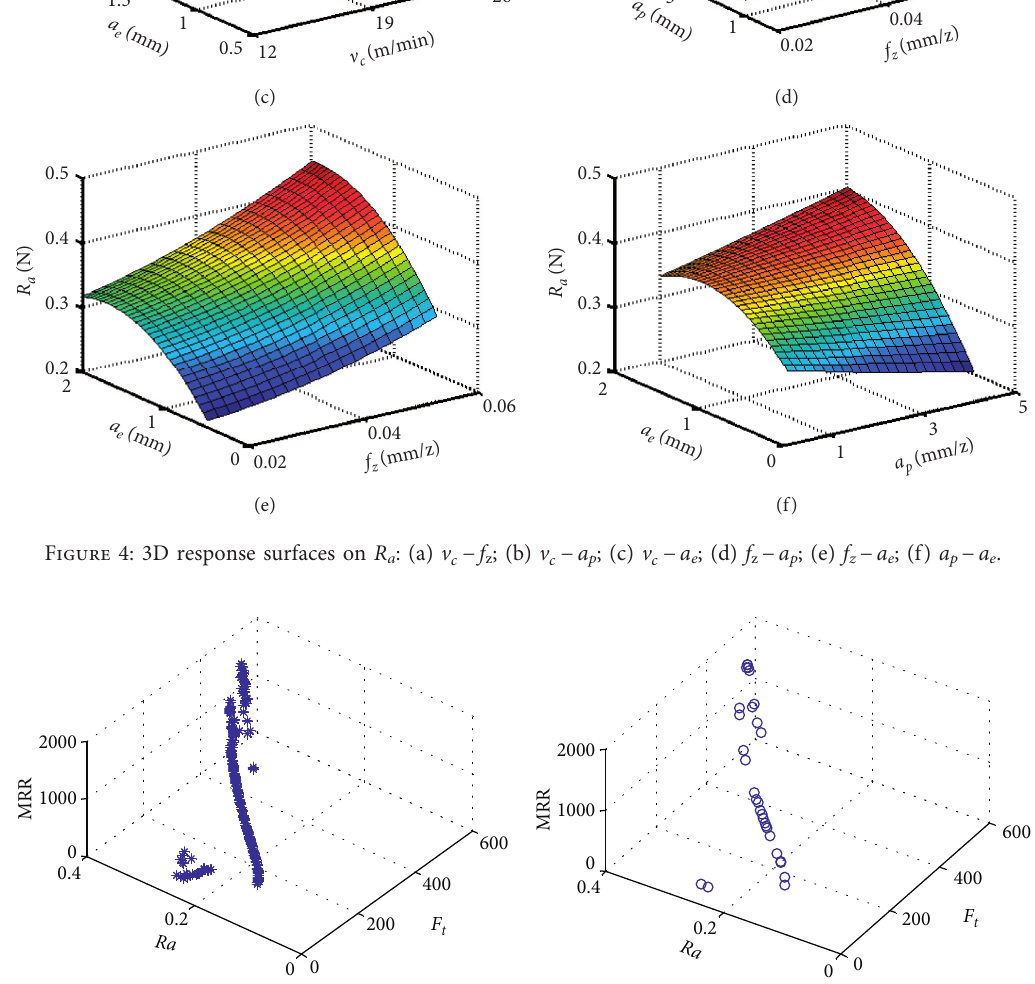
Figure 5: Pareto-optimal solution set. (a) Pareto-optimal surface. (b) The distribution of 30